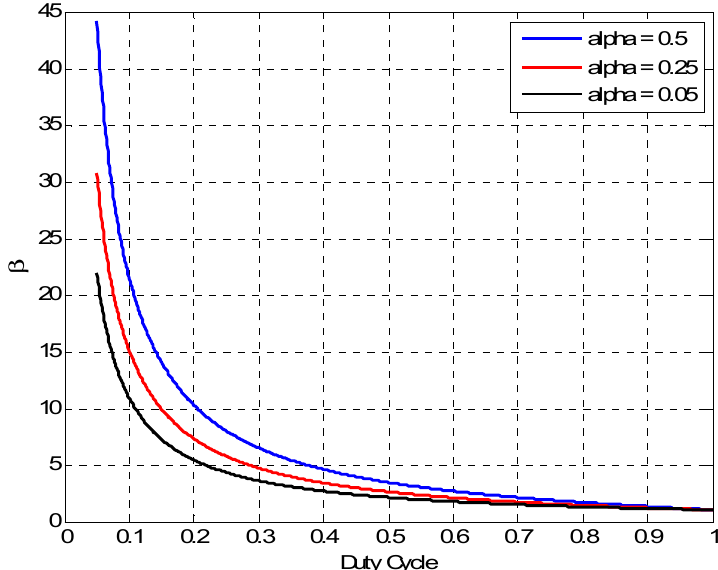
Figure 14. HIF curves for a number of BSF values.